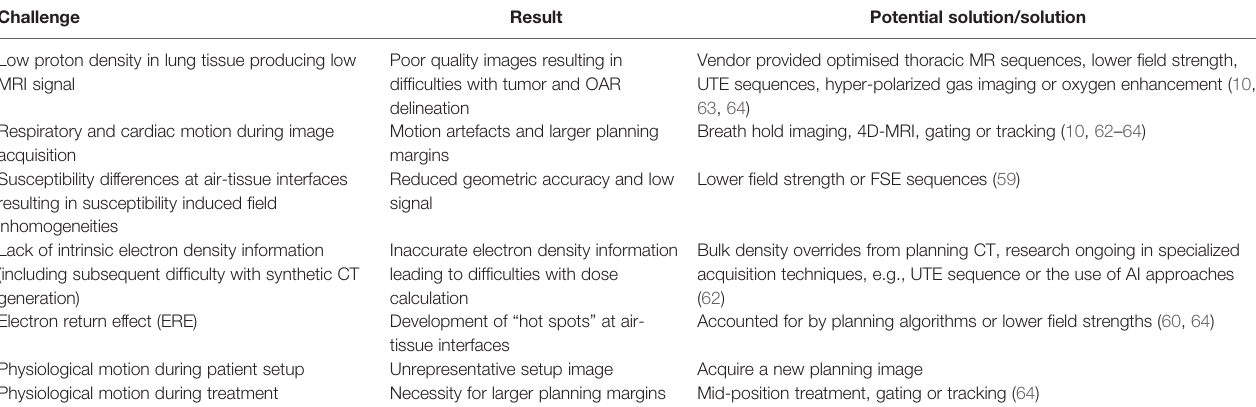
TABLE 2 | Technical challenges and potential solutions associated with MRgRT in the